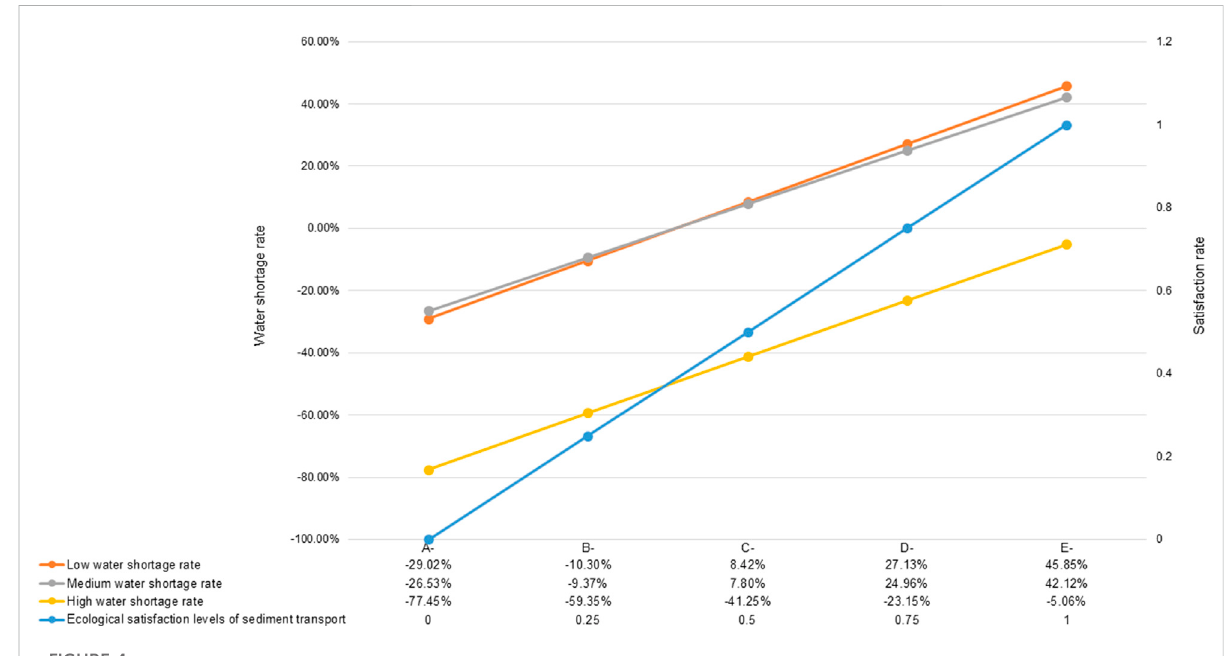
FIGURE 4 Changes in satisfaction and water shortage rate under different scenarios (2030)